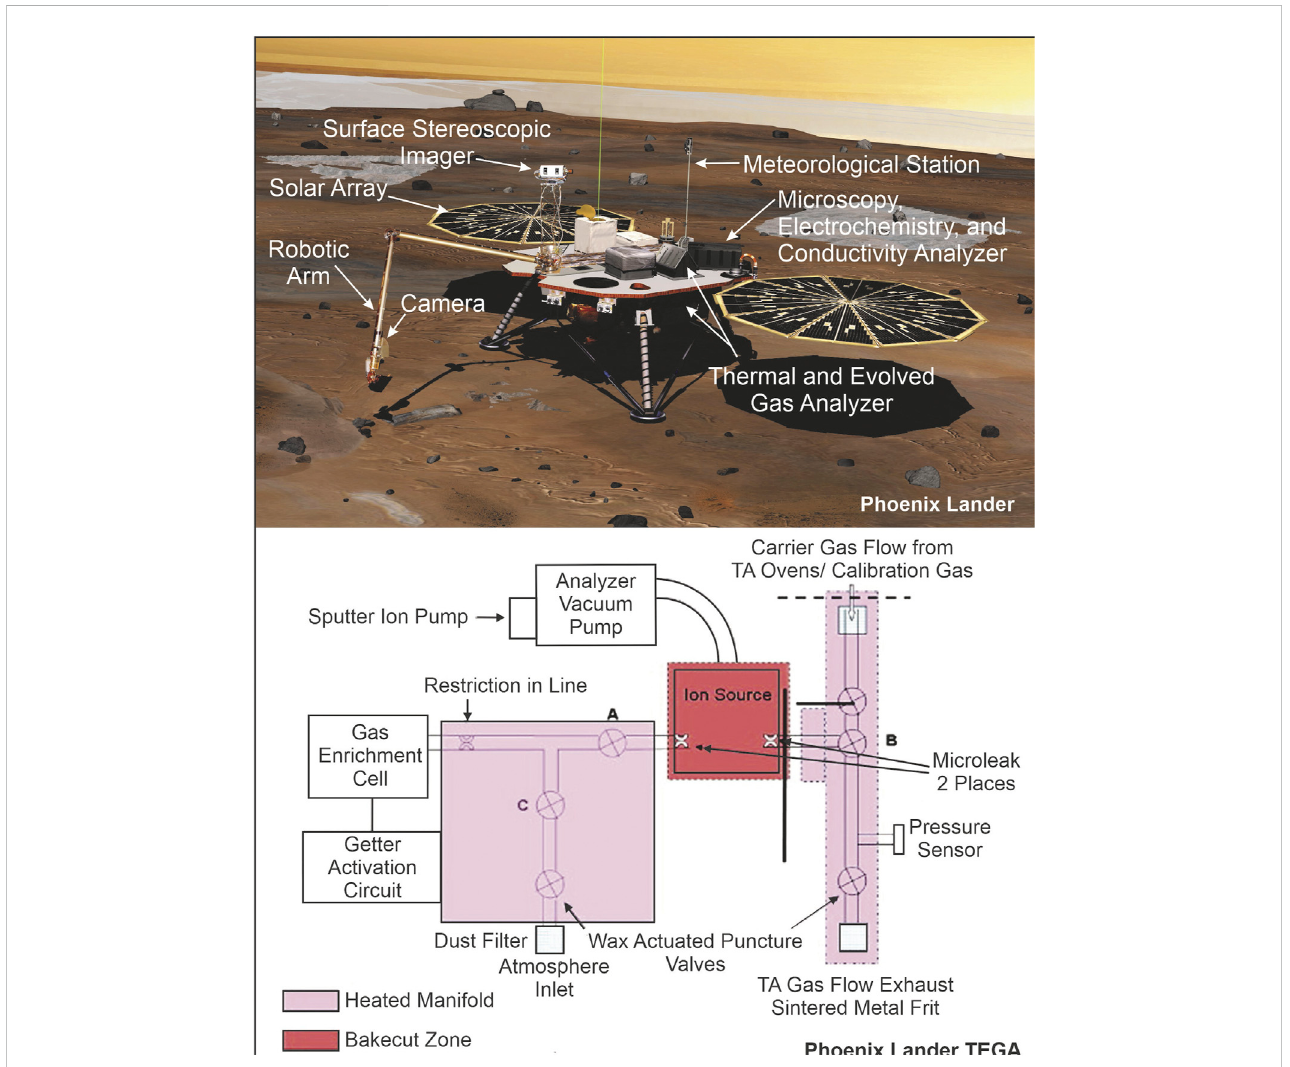
FIGURE 2 Phoenix Lander and TEGA instruments [sources: Huidobro et al. (2022) and NASA (2008)].